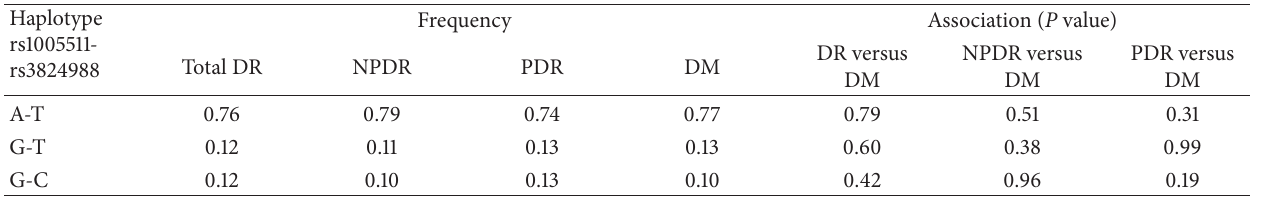
Table 4: Haplotype association of SERPING1 gene with DR and its